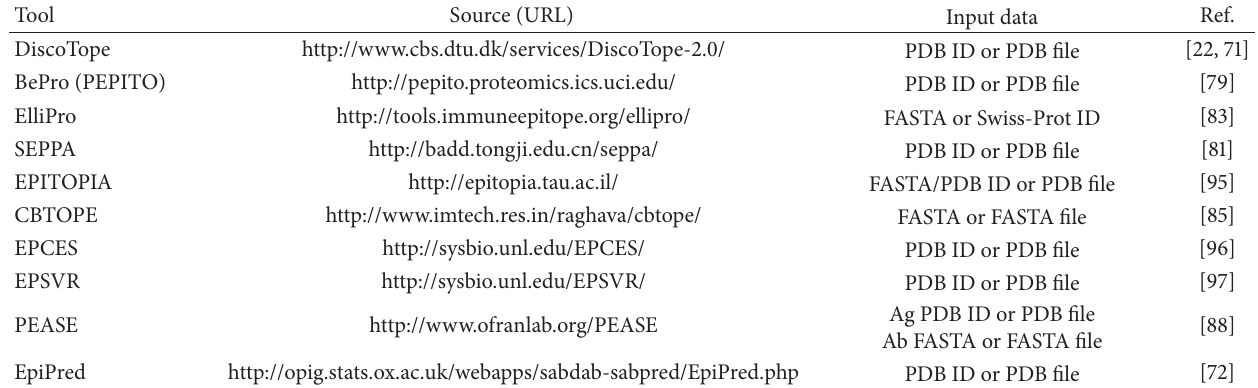
Table 3: List of web available tools for discontinuous/conformational B-cell epitope